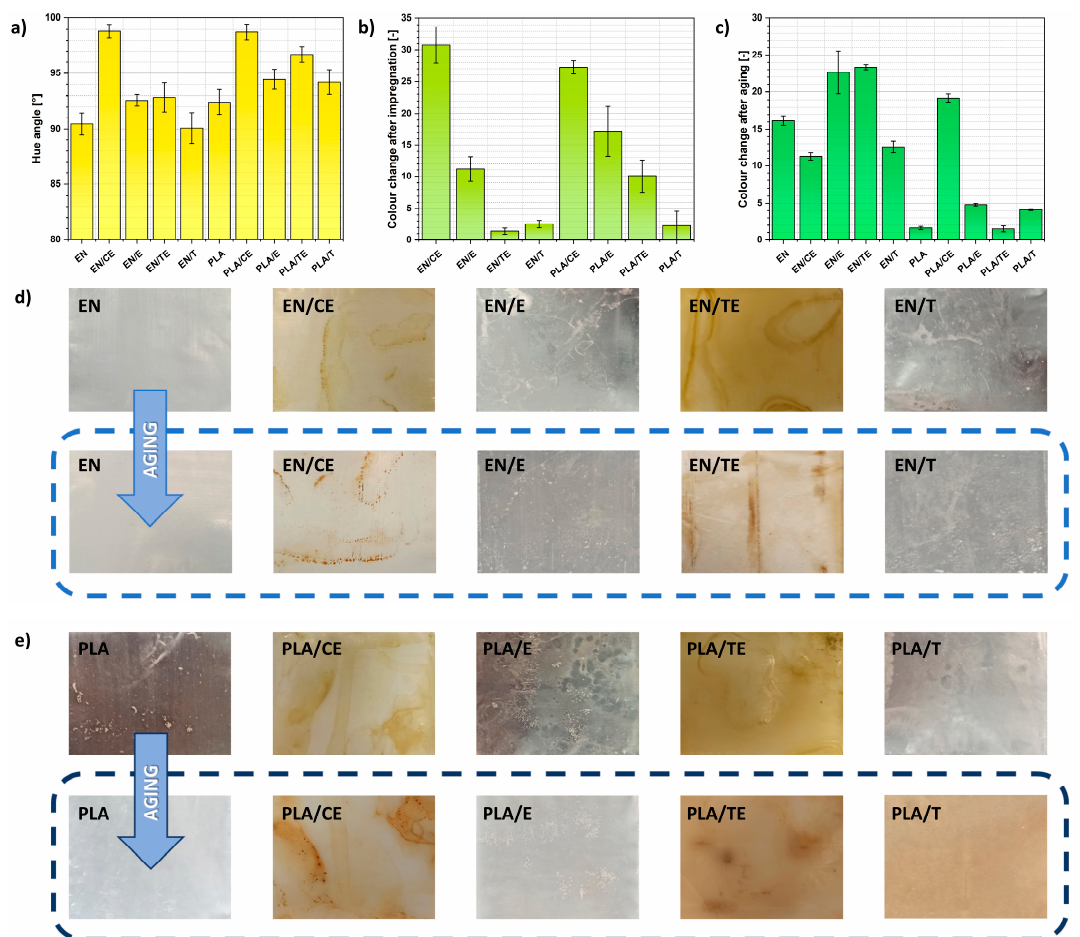
Figure 6. Color parameters of the polymer samples: specimens’ hue angle ( a ), color change after impregnation ( b ), color change while subjected to solar aging ( c ), as well as the pictures representing the specimens of ethylene–norbornene copolymer ( d ) and poly(lactic acid) ( e ) before and after the aging process. Photos taken on a black background.